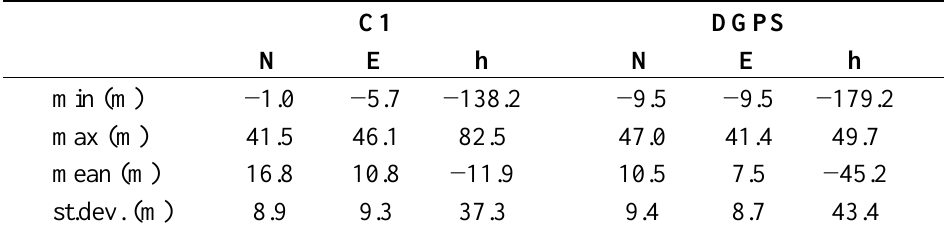
Table 2. Statistics of autonomous and DGPS solutions under adverse